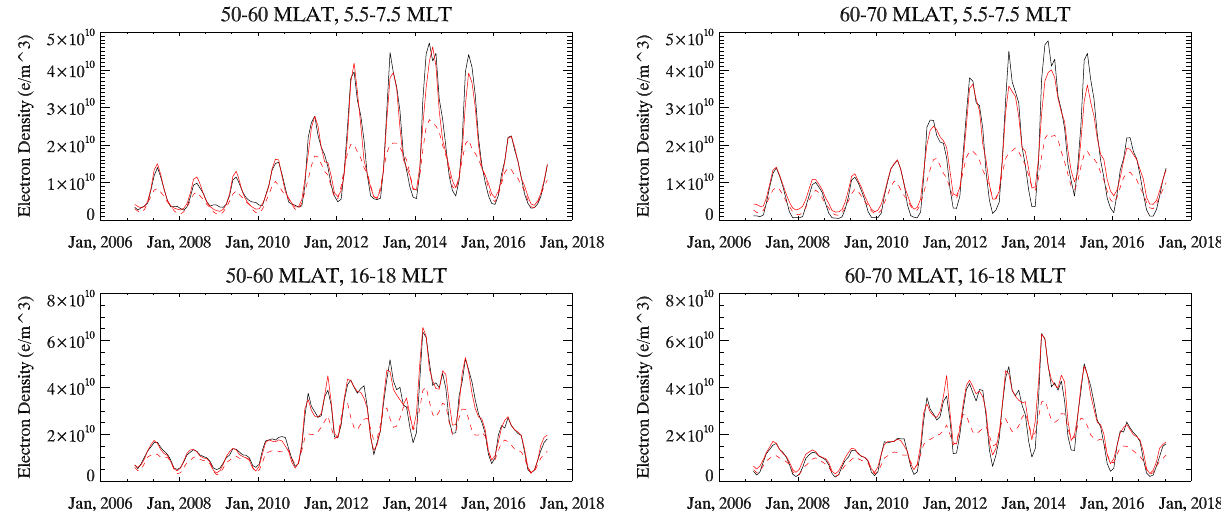
Fig. 4. Plots of monthly mean electron density from DMSP F17 (black line) and the E-CHAIM (red solid line) and IRI (red dashed line) models at the DMSP F17 satellite orbit. The top plots correspond to the 5.5 – 7.5 MLT bin, the bottom plots correspond to the 16 – 18 MLT bin, the left plots are for the 50 – 60 (cid:1) N geomagnetic latitude bin, and the right plots are for the 60 – 70 (cid:1) N geomagnetic latitude